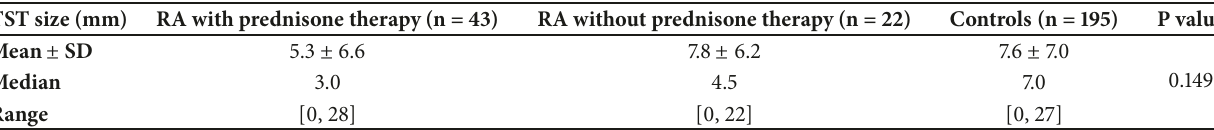
Table 2: Mean and median TST sizes in RA patients treated with prednisone and RA patients not treated with prednisone and controls. TST si z e